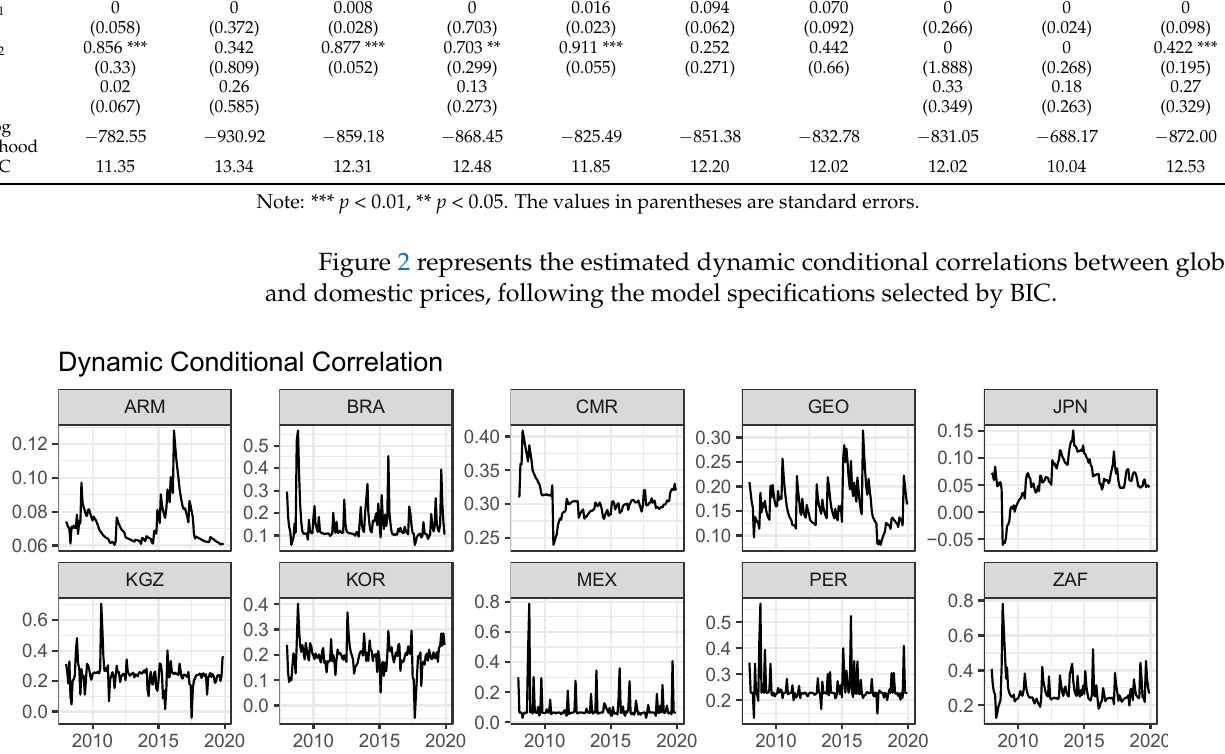
Table 6. Results of DCC-GARCH models.